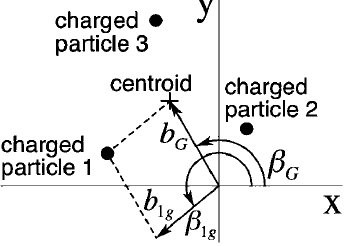
FIG. 2. Exampleconfigurationofatypicalthree-particlesystem.